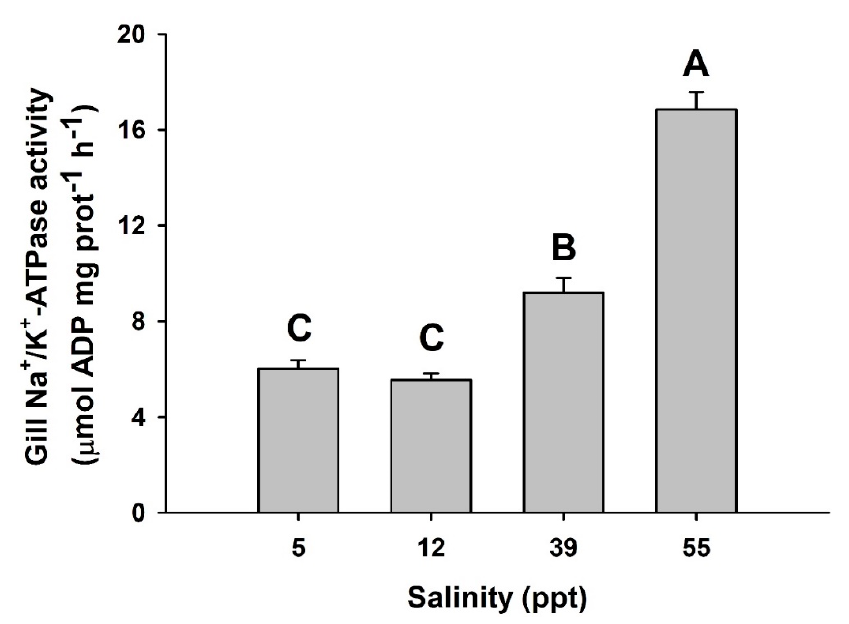
Figure 2. Gill Na + /K + -ATPase (NKA) activity in A. regius juveniles acclimated to different environmental salinities (5, 12, 39, and 55 ppt) for 21 days. Results are expressed as the mean ± SEM ( n = 7–10). Different letters indicate significantly different groups ( p < 0.05, one-way ANOVA followed by Tukey’s post-hoc test).